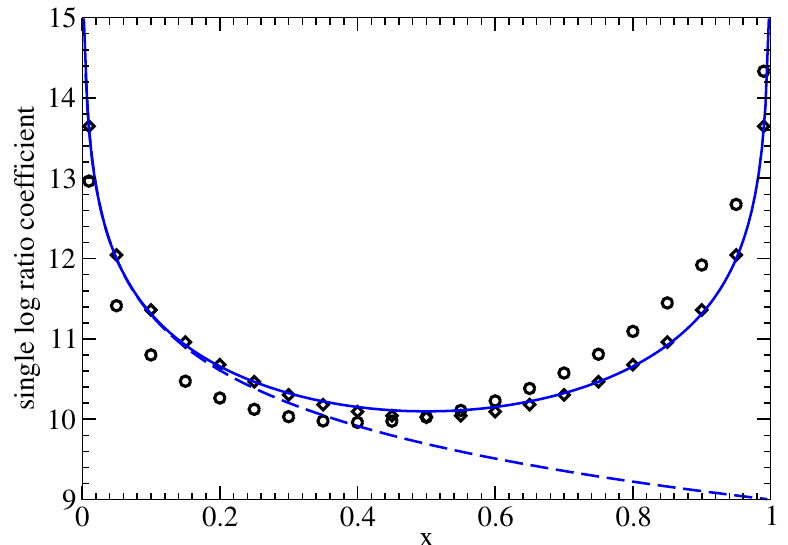
Figure 19 . The single-log coe(cid:14)cients s (circles) and (cid:22) s (diamonds) as a function of x . The left-most and right-most data points are for x = 0 : 01 and x = 0 : 99, while all other data points are evenly spaced at x = 0 : 05, 0 : 10, 0 : 15, ..., 0 : 85, 0 : 90, 0 : 95. For comparison, the dashed blue curve shows the anticipated small- x behavior (4.9) with constant c (cid:12)t by (4.10), and the solid blue curve shows the educated guess (4.12) for the full x